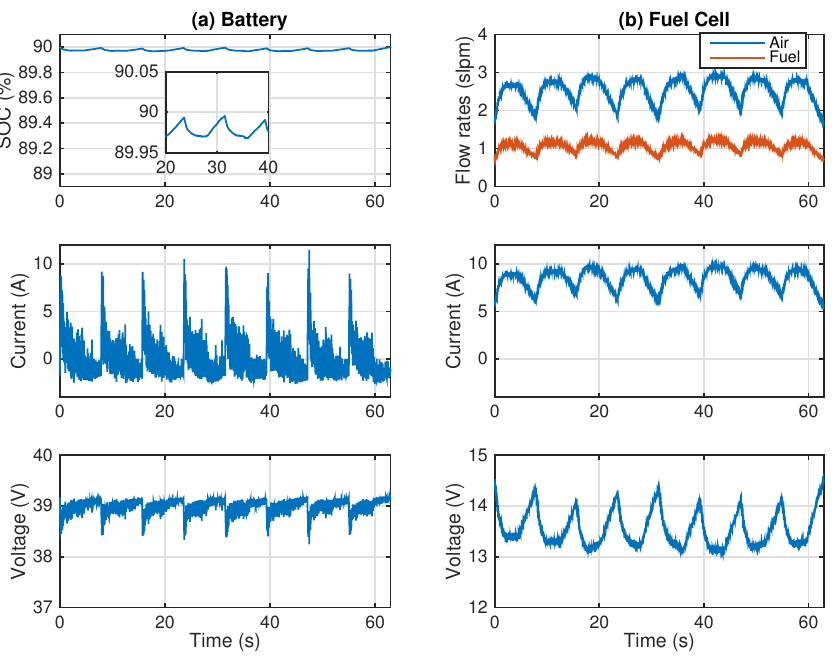
Figure 25. High-SOC full-active hybrid simulation. ( a ) Battery response and ( b ) FC